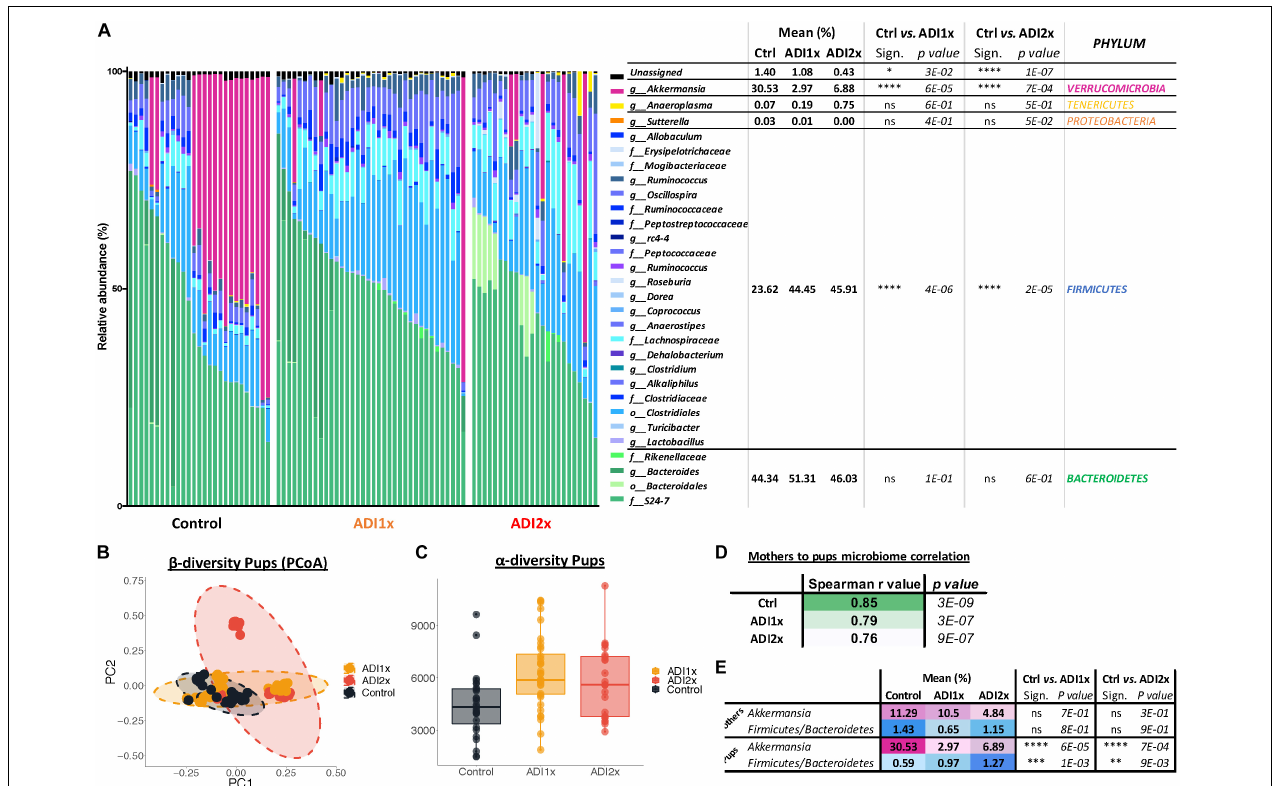
FIGURE 4 | Major microbiome changes are observed in NNS pups. (A) Summary of 16S sequencing of pup’s control, ADI1x and ADI2x gut microbiota. The mean, significance and p -value are represented at the phylum level in the right panel (Kruskal–Wallis test) ( n = 24). g_: genus; f_: family; o_: order. (B) A beta-diversity analysis (Principal Coordinate Analysis (PCoA- unweighted unifrac) of control, ADI1x and ADI2x microbiome sequencing ( n = 24). (C) An alpha-diversity analysis [observed operational taxonomic units (OTUs)] of control, ADI1x and ADI2x microbiome sequencing ( n = 24). (D) The Spearman correlation and p -value measures of mothers and pups’ microbiome ( n = 24). (E) The changes observed in mothers and pups in verrucomicrobia levels and firmicutes/bacteroidetes ratio (Kruskal–Wallis test) ( n = 24). Significance values: ∗∗∗∗ p < 0.001, ∗∗∗ p < 0.005, ∗∗ p < 0.01, ∗ p <